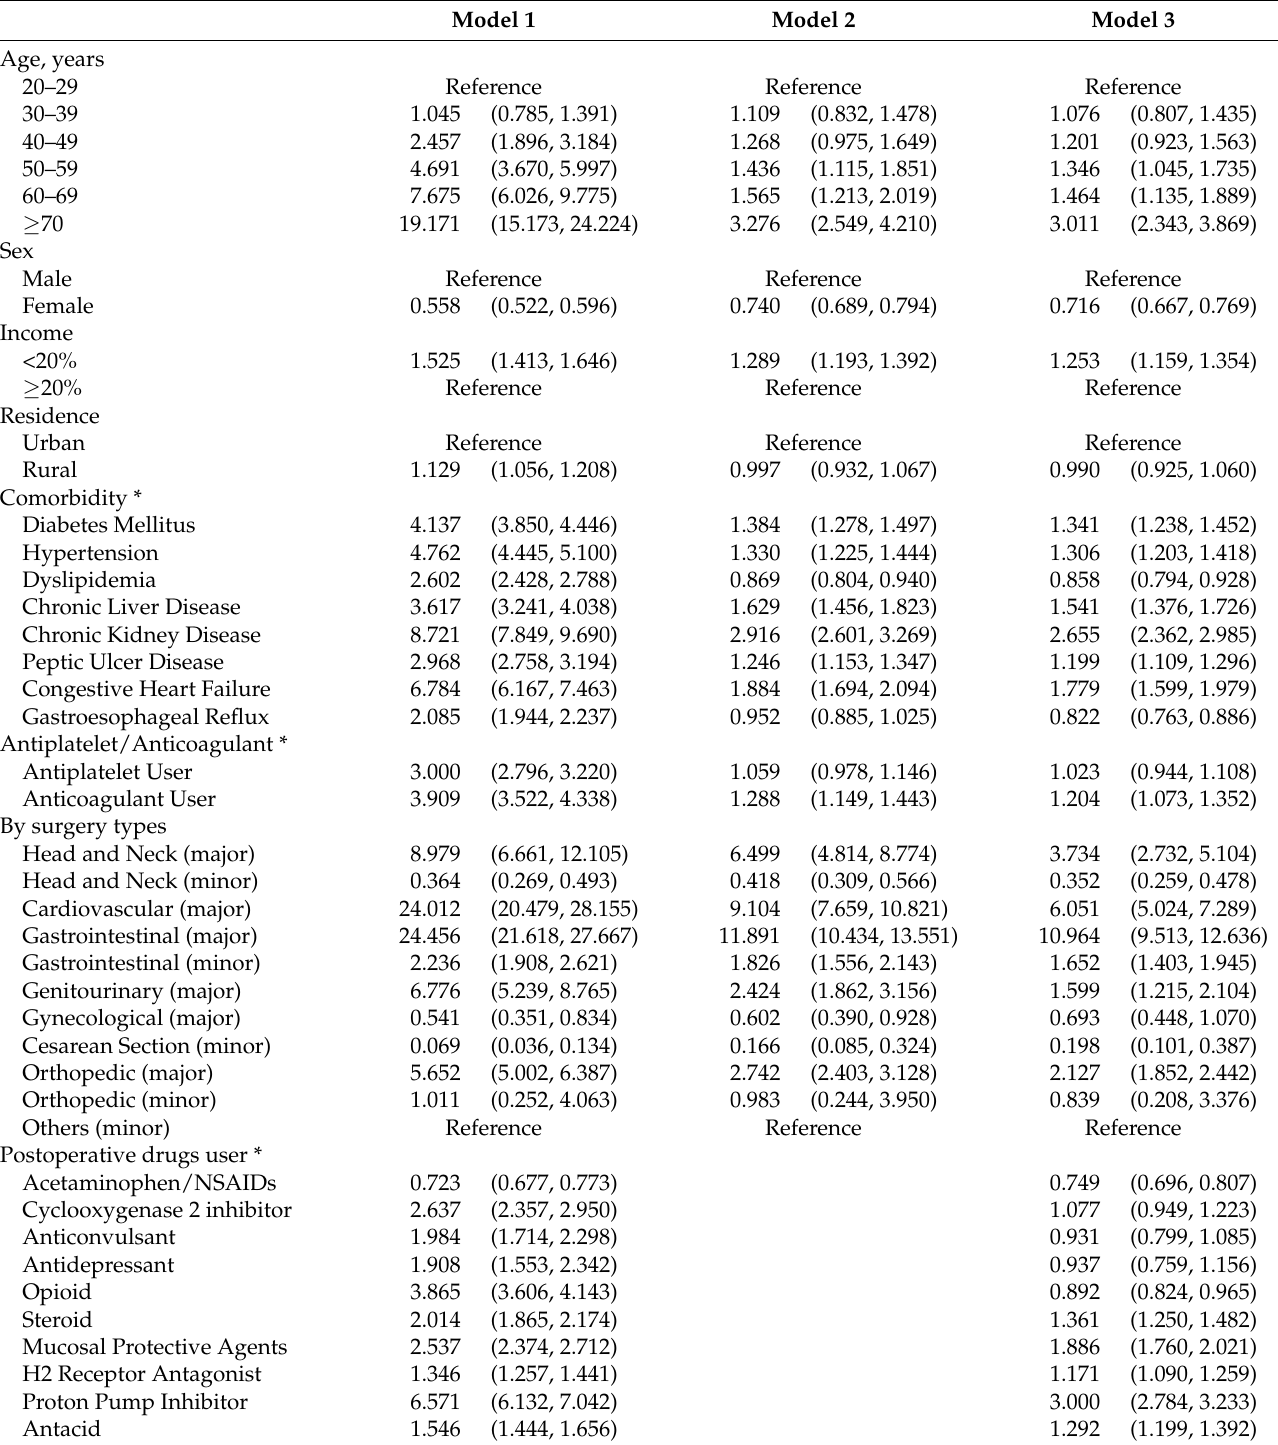
Table 3. Logistic regression analysis for postoperative gastrointestinal bleeding risk (odds ratio, 95% confidence